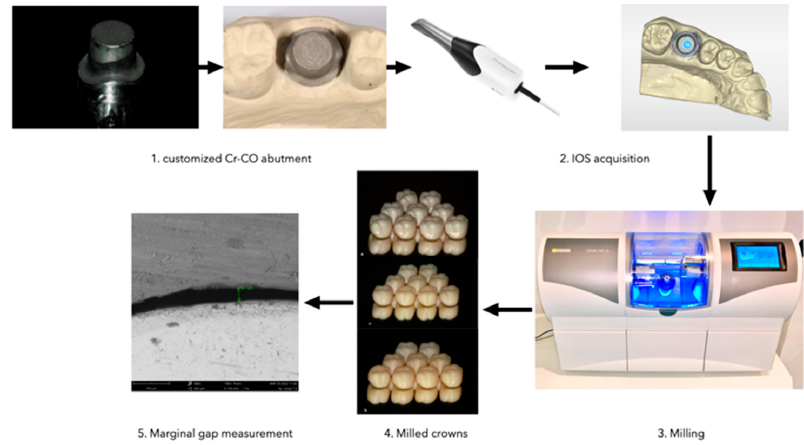
Figure 6. Schematic representation of the experimental design work fl ow.